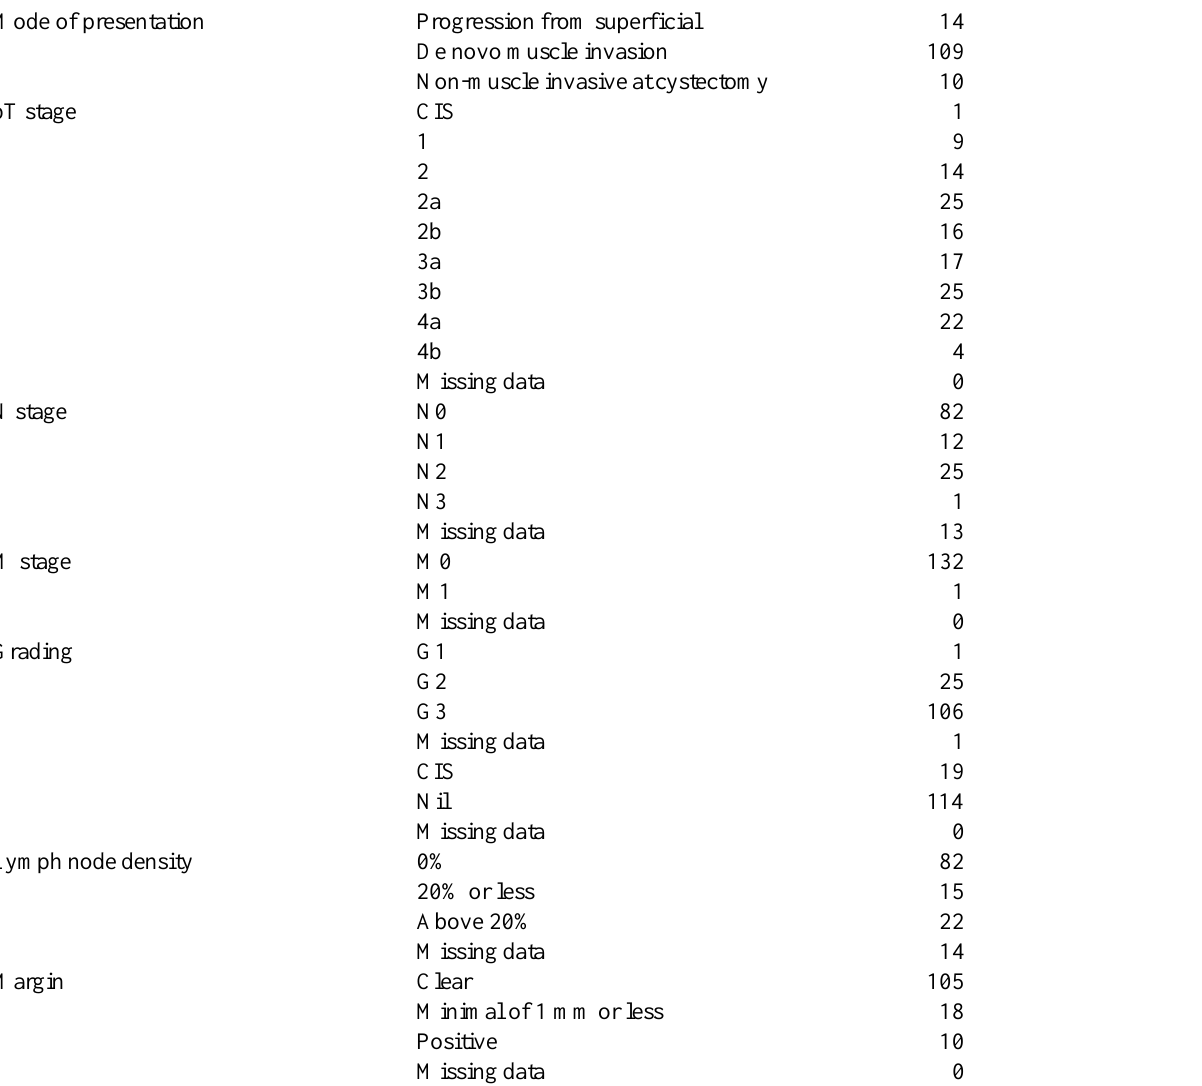
Table 1 – Number of patients with different histological